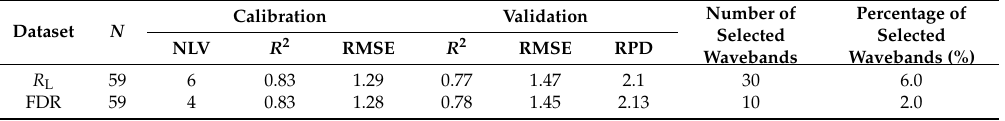
Table 4. The coefficient of determination ( R 2 ) and root mean square error (RMSE) for calibration of iterative stepwise elimination partial least squares (ISE-PLS) and leave-one-out (LOO) cross-validation using the entire dataset ( N = 59), with residual predictive deviation (RPD), number of wavebands, and percent ratio in the full spectrum ( i = 501).